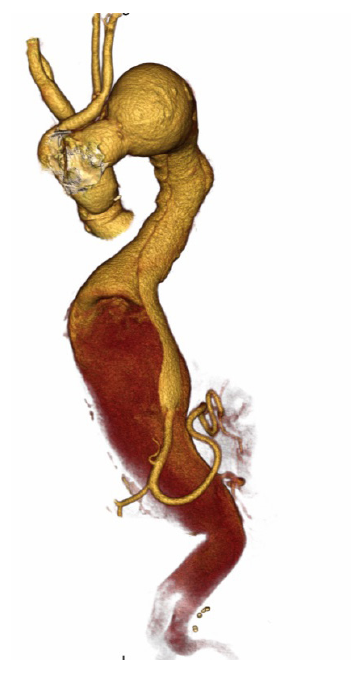
Fig. 2 - Postoperative computed tomography angiography of the patient.